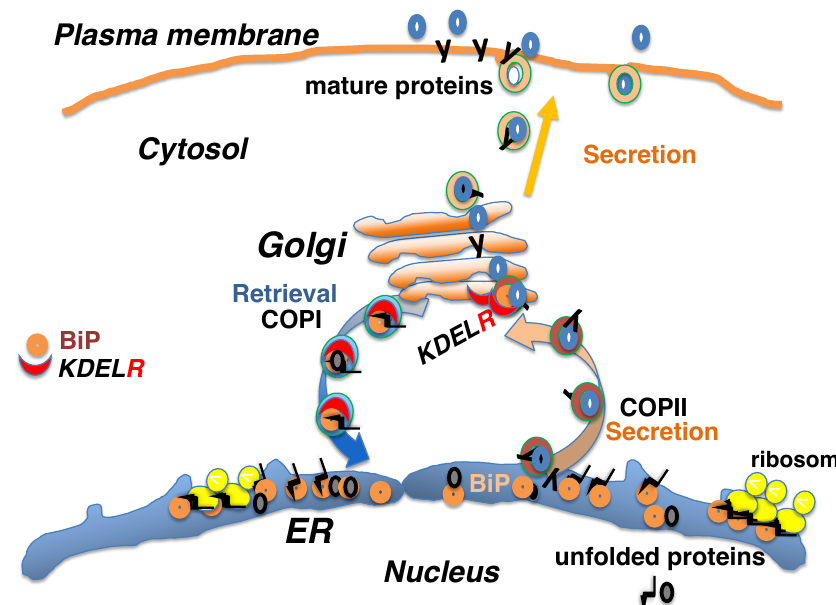
Figure 1. Newly synthesized peptides are incorporated into the endoplasmic reticulum (ER) and transported to the secretory pathway. Interaction with ER-resident chaperones, such as binding immunoglobulin protein (BiP), facilitates the folding of nascent proteins. Mature proteins are then released to the secretory pathway via coat protein II (COPII)-mediated vesicular transport. A fraction of the KDEL sequence-containing chaperones, like BiP, that accompany unfolded proteins are destined for secretion, while KDEL receptors (KDELRs) retrieve escaped chaperones from the cis -Golgi and deliver them to the ER through coat protein I (COPI)-mediated vesicular